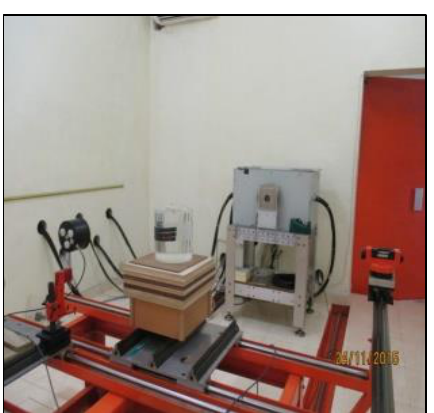
Figure 2. TLD-700H with headband on the surface of Cylindrical phantom